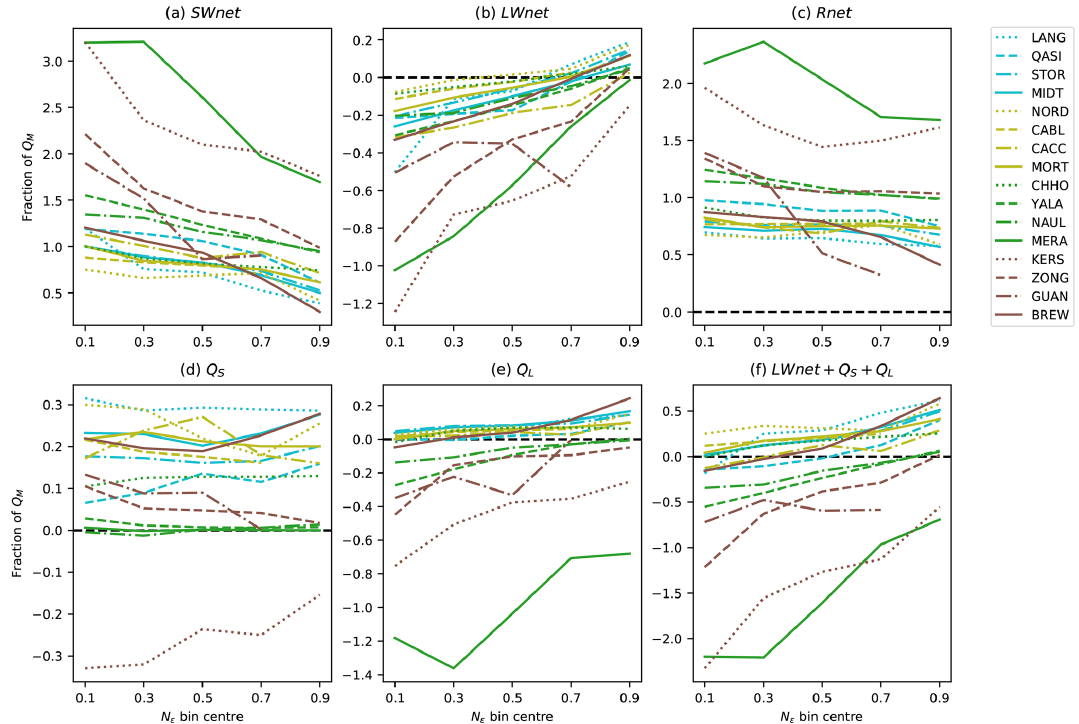
Figure 11. Average melt-season SEB terms during hours with surface melt for different cloud conditions ( N ε ). Variables are shown as a fraction of average Q M during hours with surface melt in each respective cloud condition ( N ε ). Note that the y -axis range differs between